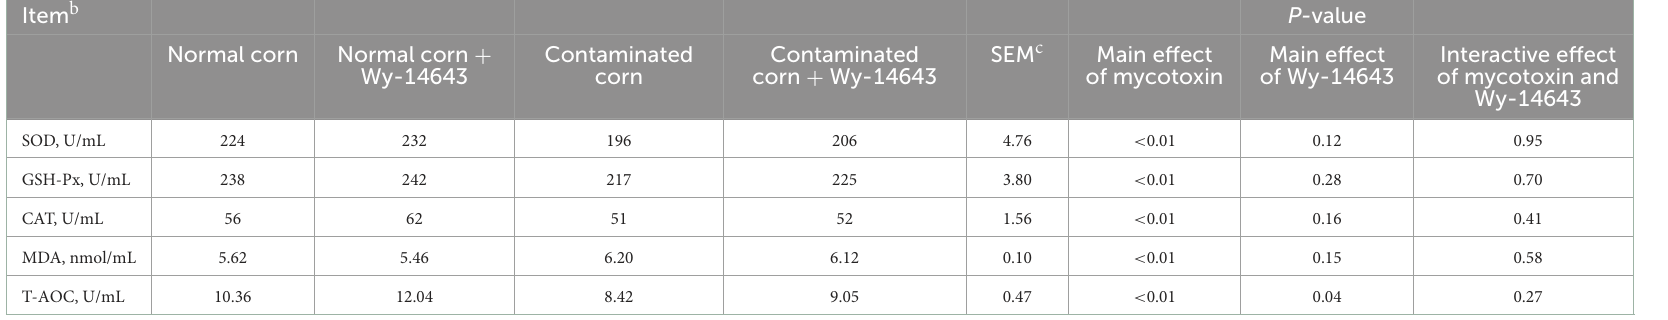
TABLE 5 Effects of PPAR- α agonist on antioxidant activity in broilers fed mycotoxin-contaminated corn a